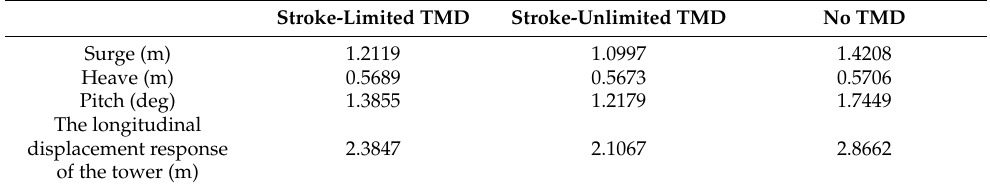
Table 18. Motion RMS with or without TMD stroke limitation under storm self-survival conditions.